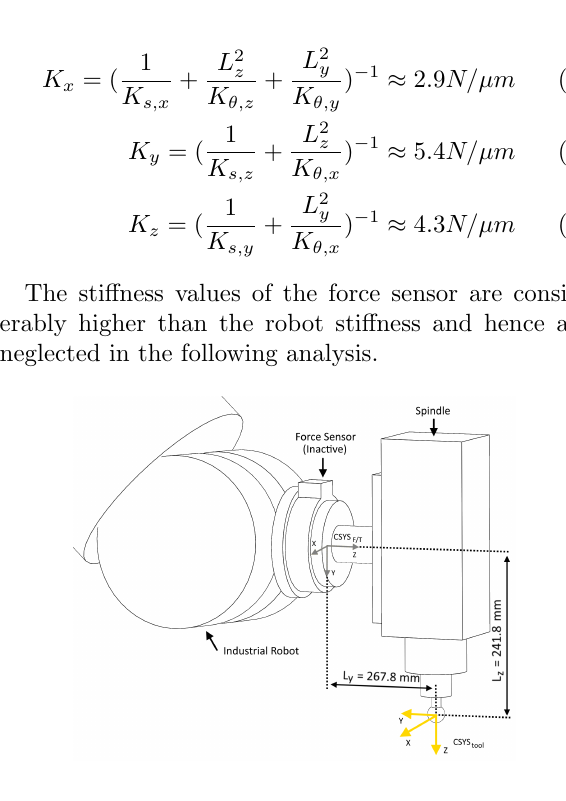
Figure 14: 6-DOF industrial robot: tool offset from the inactive ATI Omega160 force/torque sen- sor.